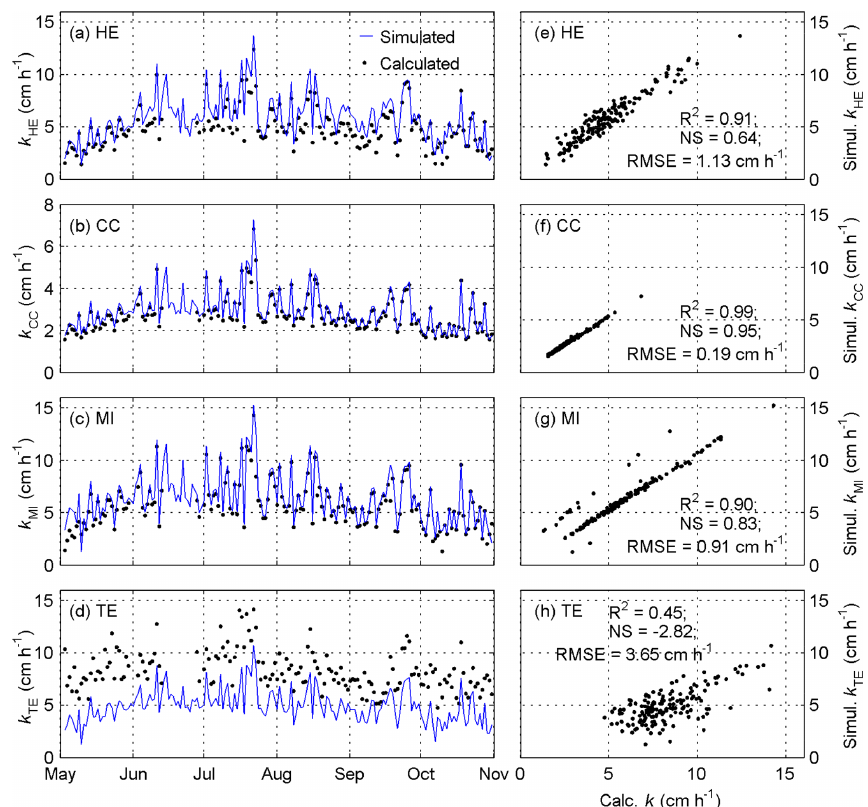
Figure 3. Simulated and calculated gas transfer velocities for CO 2 (cmh − 1 ) in Lake Kuivajärvi on 3 May–31 October 2013 obtained with the gas exchange models by (a, e) Heiskanen et al. (2014), (b, f) Cole and Caraco (1998), (c, g) MacIntyre et al. (2010), and (d, h) Tedford et al. (2014).